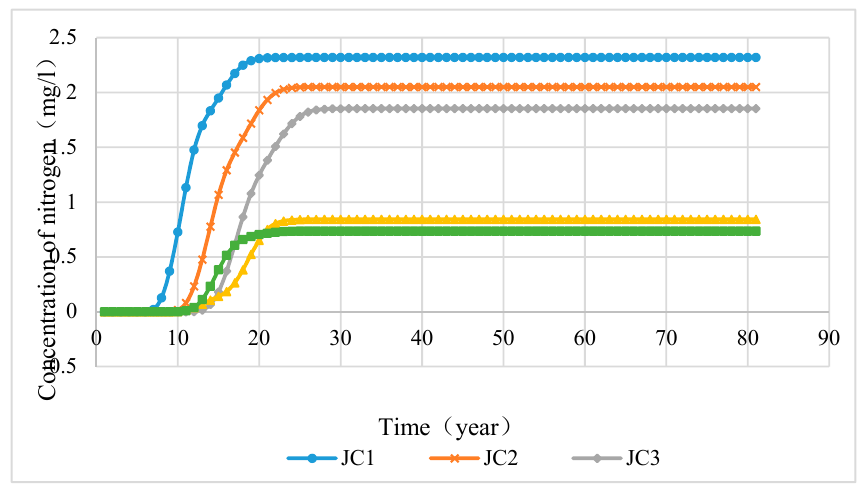
Figure 11. Ammonia nitrogen concentration changing curves of five monitoring wells without pumping.